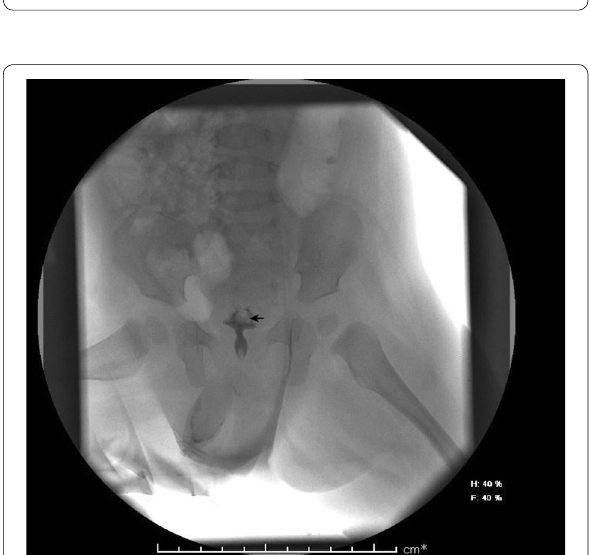
Fig. 2 Post-void film of micturition cystogram showing the silhouette of the left ureterocele within the bladder (black arrow)